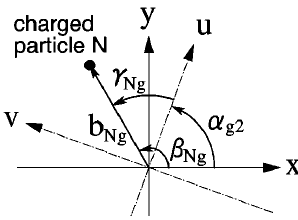
FIG. 3. Definition of rotated axes u , v